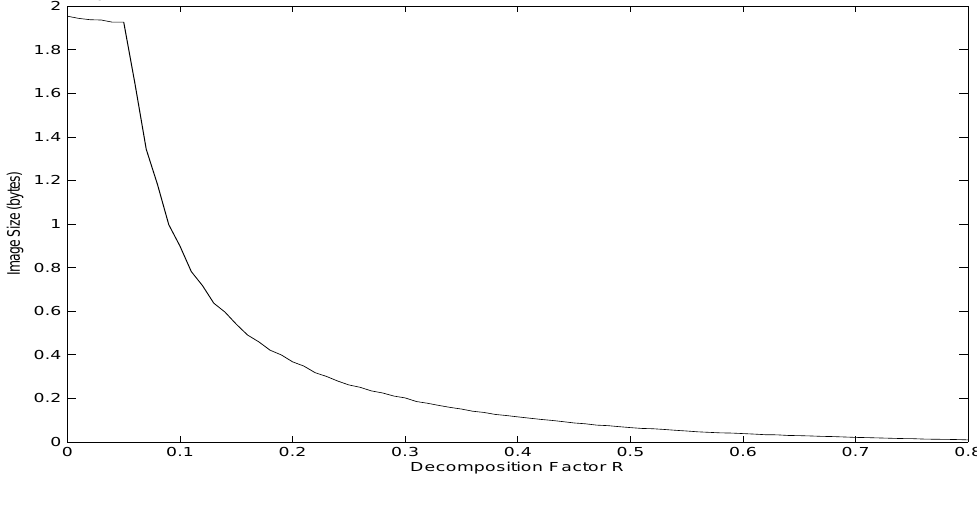
Figure 4 . Effect of the decomposition factor R on the QTD resulting image size.